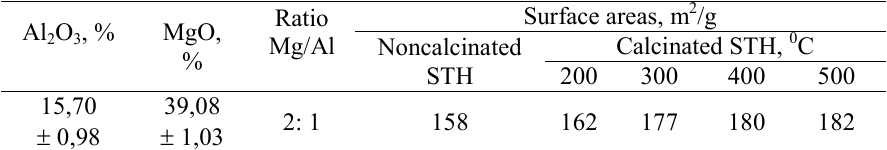
Table 1. Characteristic of synthesized STH.